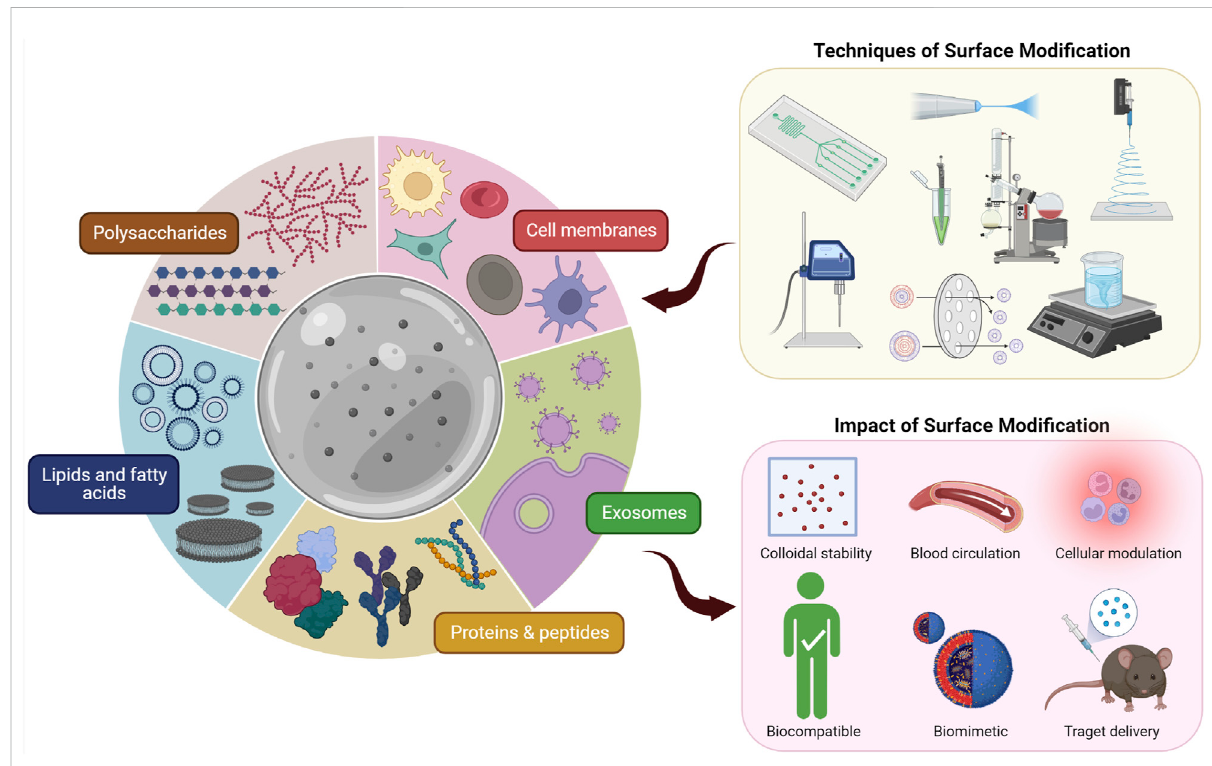
FIGURE 1 Different techniques of surface modi fi cation of micron- and nano-scale biomaterials using biological membranes and biomolecules and the impact